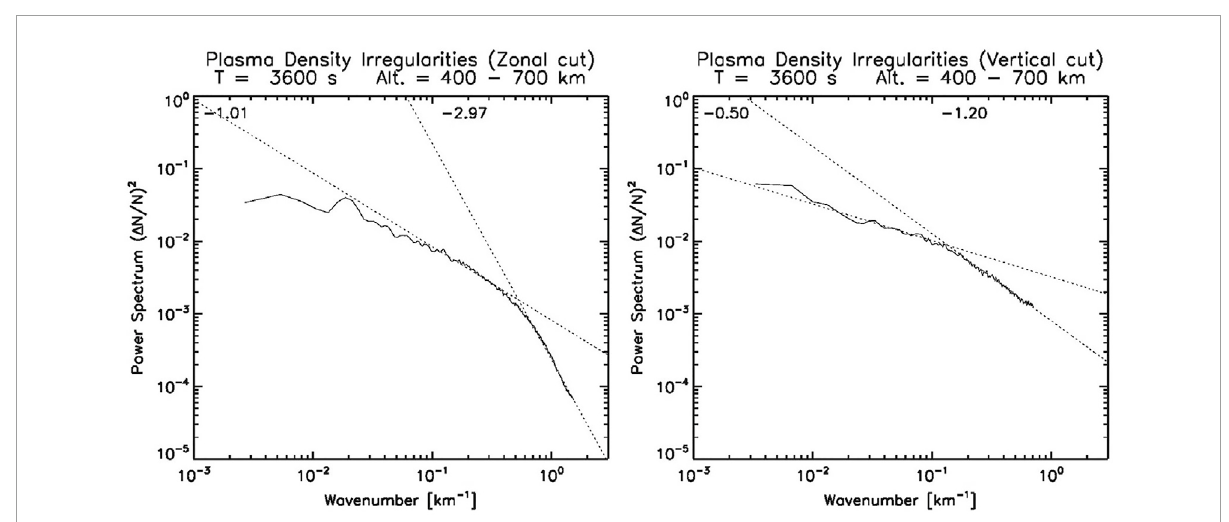
FIGURE 7 Power spectral density plots of irregularities from a high-resolution computational model (from Yokoyama,